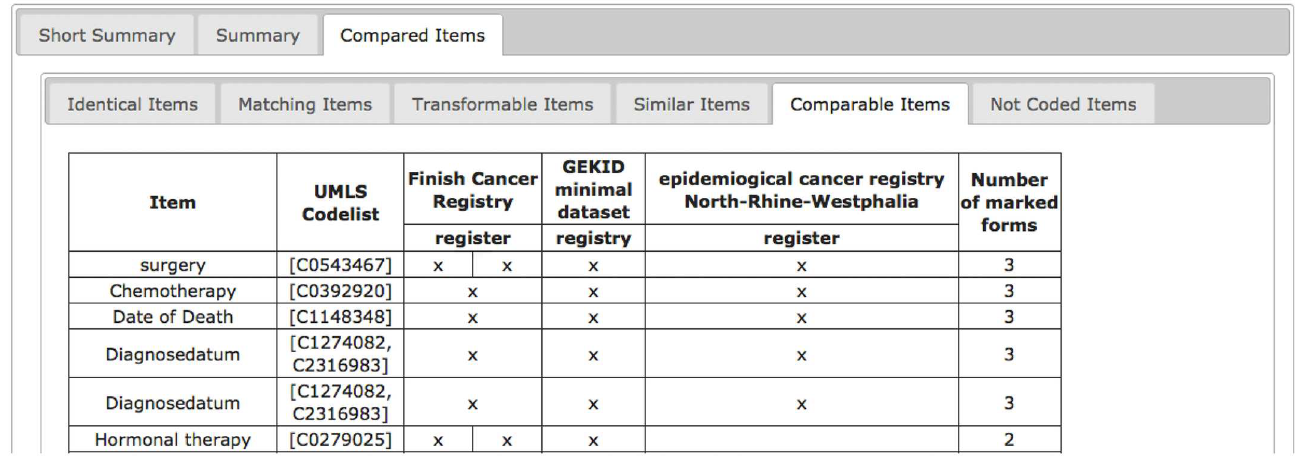
Fig 8. Output of a form comparison showing comparable items in three different registries. The three registries includeseveral comparable items like “Chemotherapy” and the Finish Cancer Registry even contains the item “surgery”